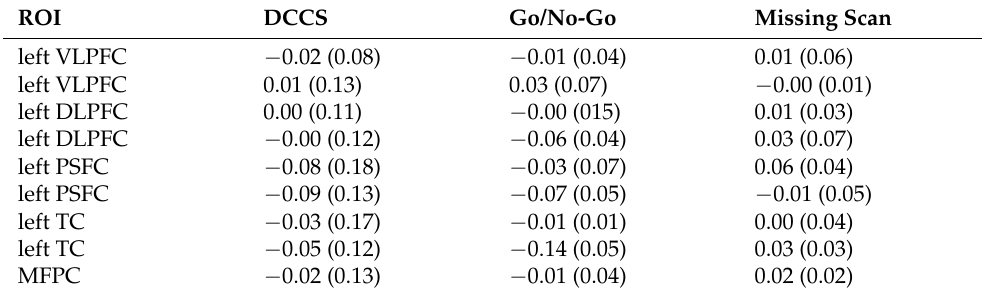
Table 2. Mean ( SD ) of Changes in HbO during The Task Phases after Subtracting Rest Phases. ROI DCCS Go/No-Go Missing Scan left VLPFC − 0.02 (0.08) − 0.01 (0.04) 0.01 (0.06) left VLPFC 0.01 (0.13) 0.03 (0.07) − 0.00 (0.01) left DLPFC 0.00 (0.11) − 0.00 (015) 0.01 (0.03) left DLPFC − 0.00 (0.12) − 0.06 (0.04) 0.03 (0.07) left PSFC − 0.08 (0.18) − 0.03 (0.07) 0.06 (0.04) left PSFC − 0.09 (0.13) − 0.07 (0.05) − 0.01 (0.05) left TC − 0.03 (0.17) − 0.01 (0.01) 0.00 (0.04) left TC − 0.05 (0.12) − 0.14 (0.05) 0.03 (0.03) MFPC − 0.02 (0.13) − 0.01 (0.04) 0.02